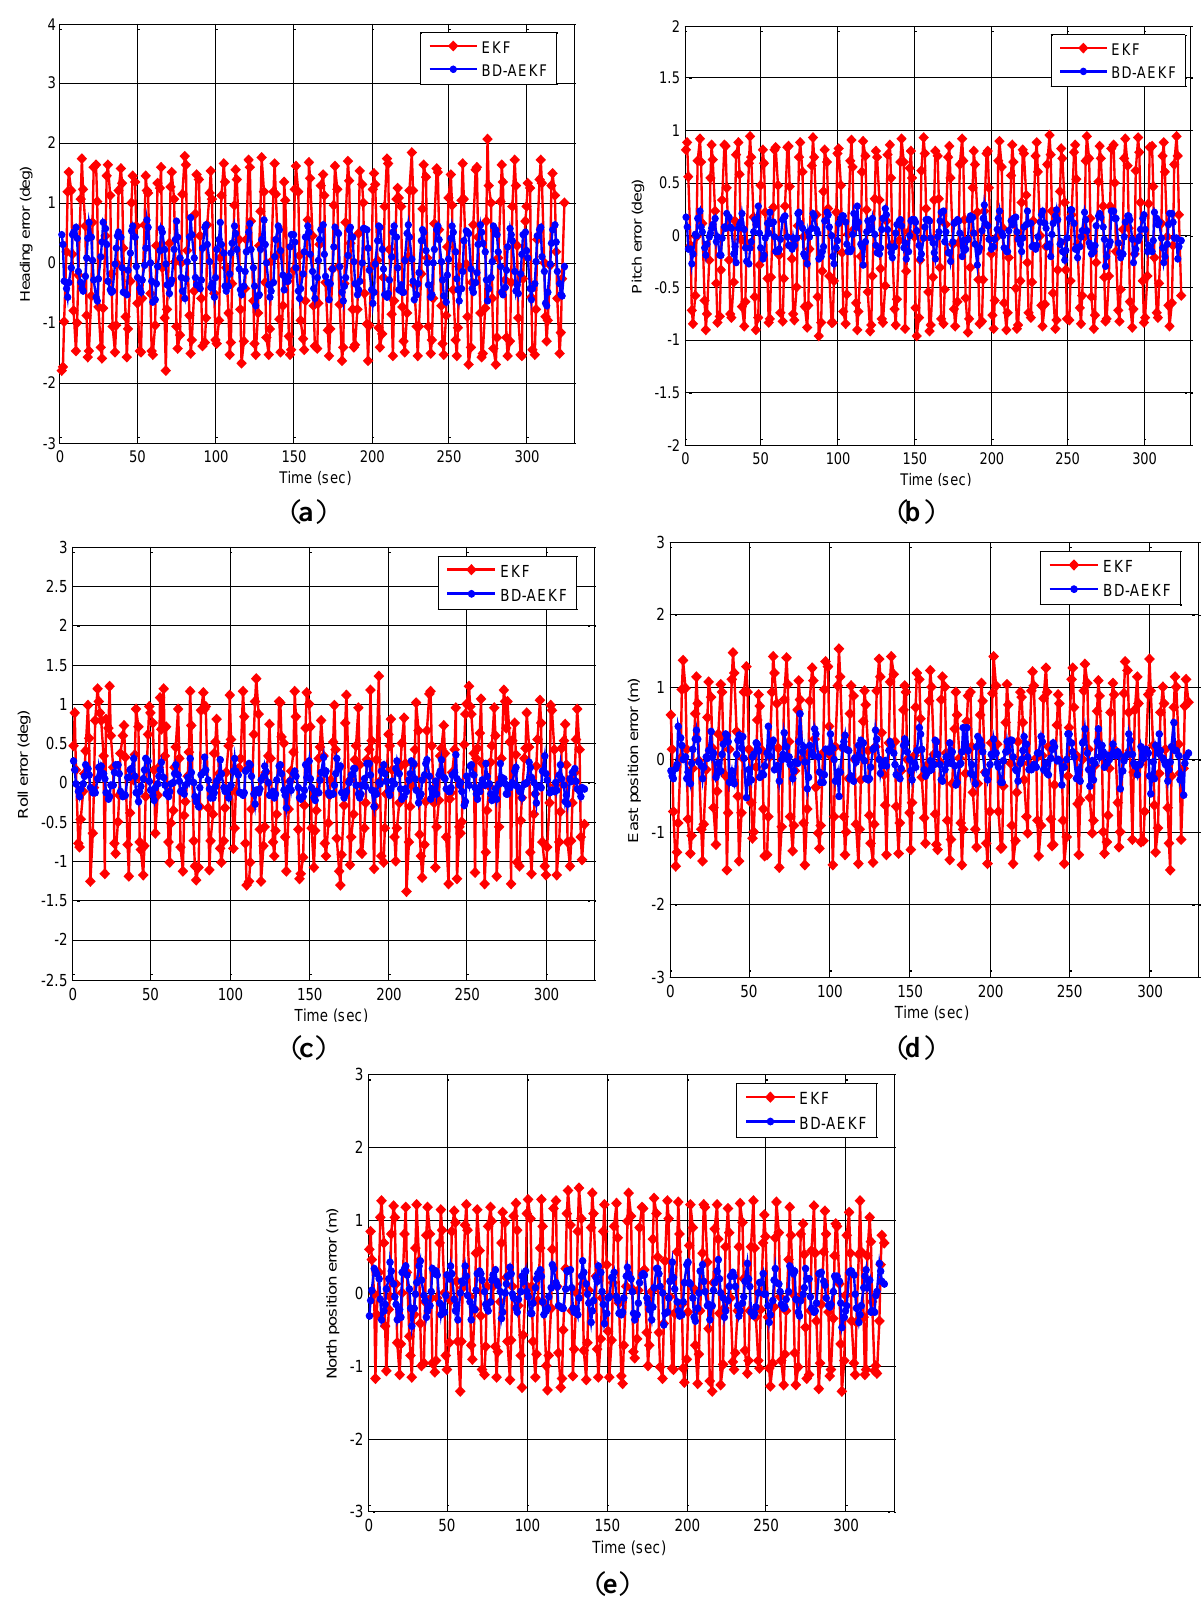
Figure 2. The attitude error and position error for EKF and BD-AEKF when the pitch changes in the sine form. ( a ) Heading ( b ) Pitch ( c ) Roll ( d ) East position ( e ) North